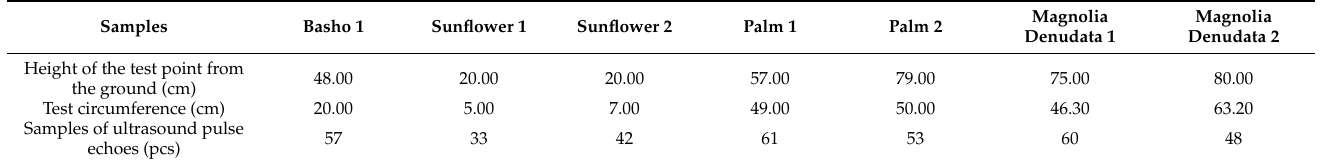
Table 3. Parameters of test data.